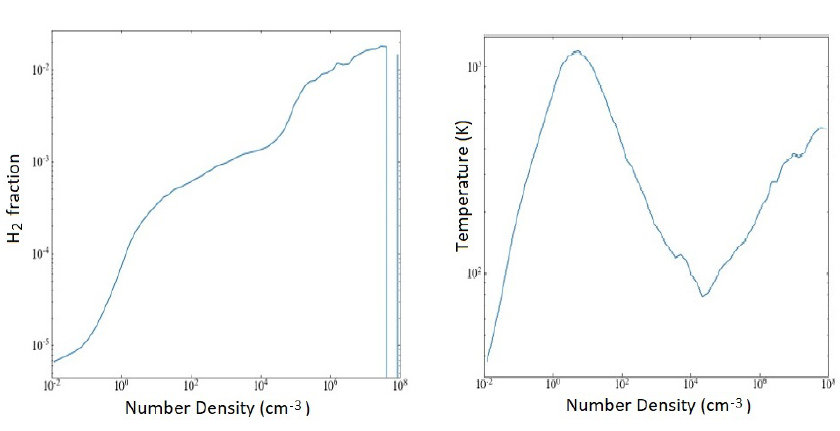
Figure 1. The Figure on the left shows the fraction of the formed H 2 molecule versus number density. The Figure on the right displays the behavior of the temperature versus number density, see text.